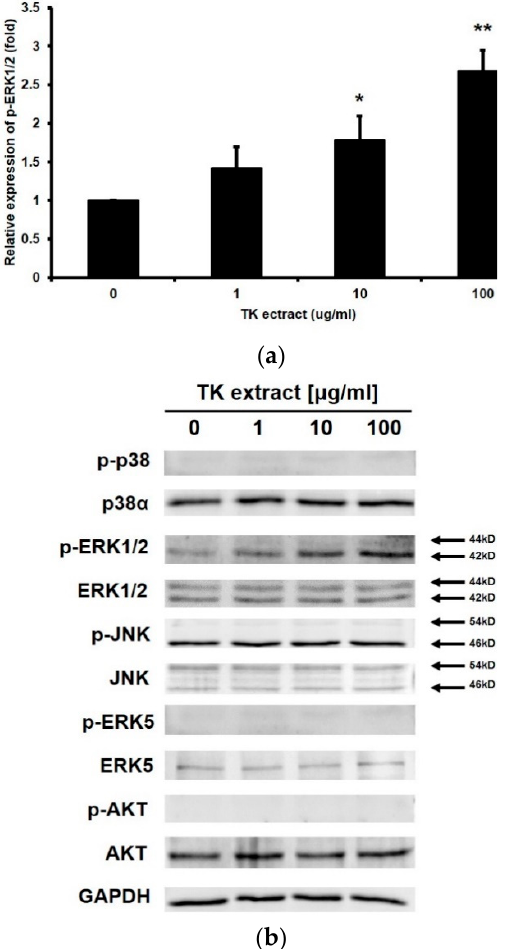
Figure 3. TK extract induced ERK1/2 phosphorylation in HaCaT cells. HaCaT cells were treated with the indicated concentration of TK extract, and the whole cell lysate proteins were used in western blot analysis. ( a ) GAPDH was used as a quantitative control. Phosphorylated forms of p38, ERK1/2, JNK, ERK5, and AKT were detected. ( b ) The p-ERK1/2 band was quantified with densitometric analysis and normalized to GAPDH. (*: p < 0.05, **: p < 0.01.)